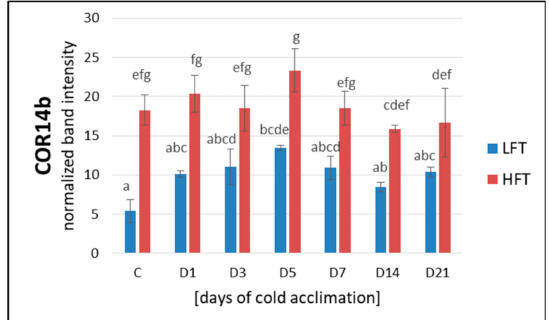
Figure 8. Accumulation level of Cor14b protein, at seven time-points: before cold acclimation (CA) C and on the 1st, 3rd, 5th, 7th, 14th, and 21st day of CA in Lolium multiflorum / Festuca arundinacea introgression forms. Error bars represent the standard errors of three replicates. Homogeneity groups are denoted by the same letters, according to Fisher’s LSD test ( p = 0.05). HFT–high freezing